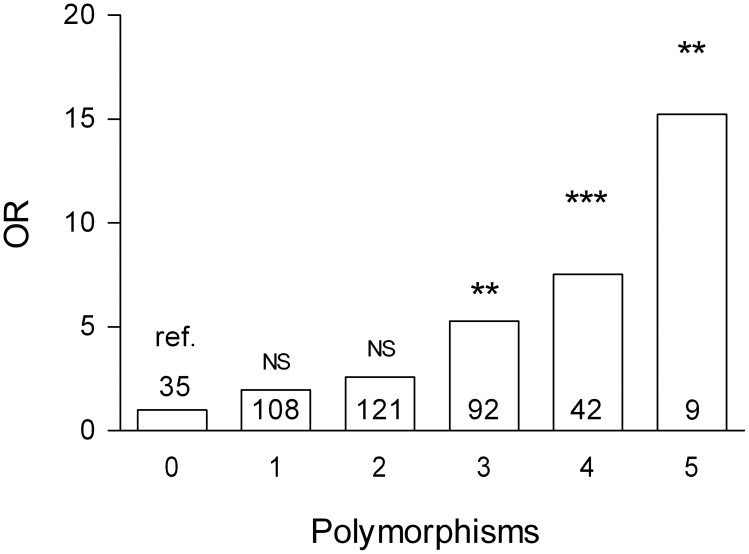
Aggregate genetic risk score.Weighted odds ratio (OR) for seropositive RA patients’ risk of EULAR non-response according to the number of associated polymorphisms, relative to patients with zero associated polymorphisms. Number of patients in bars. NS: not significant. P-value: **<0.01, ***<0.001.